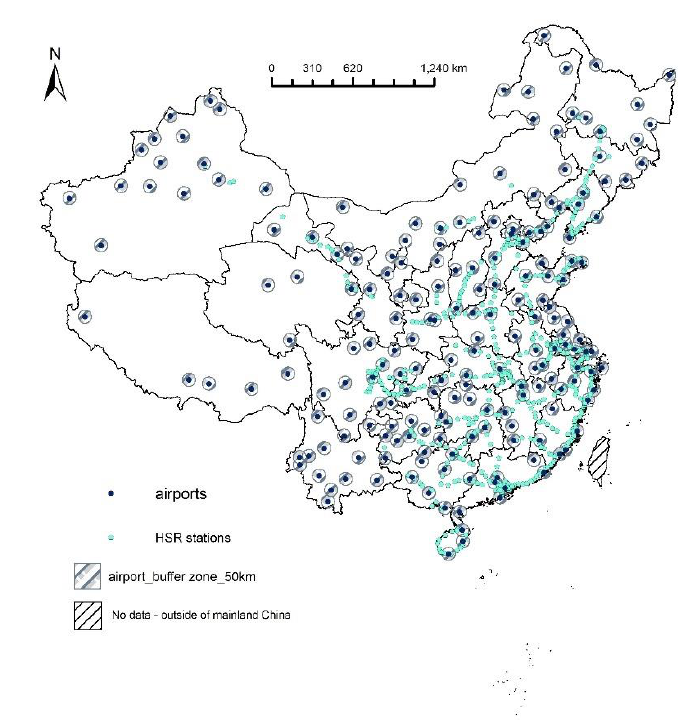
Figure 1. Airports with 50km buffer zone and HSR stations in